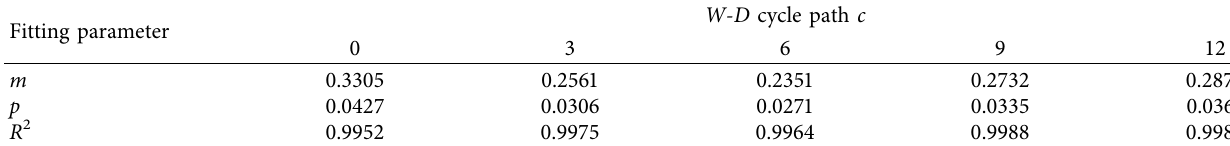
d of W-D cycle path c .